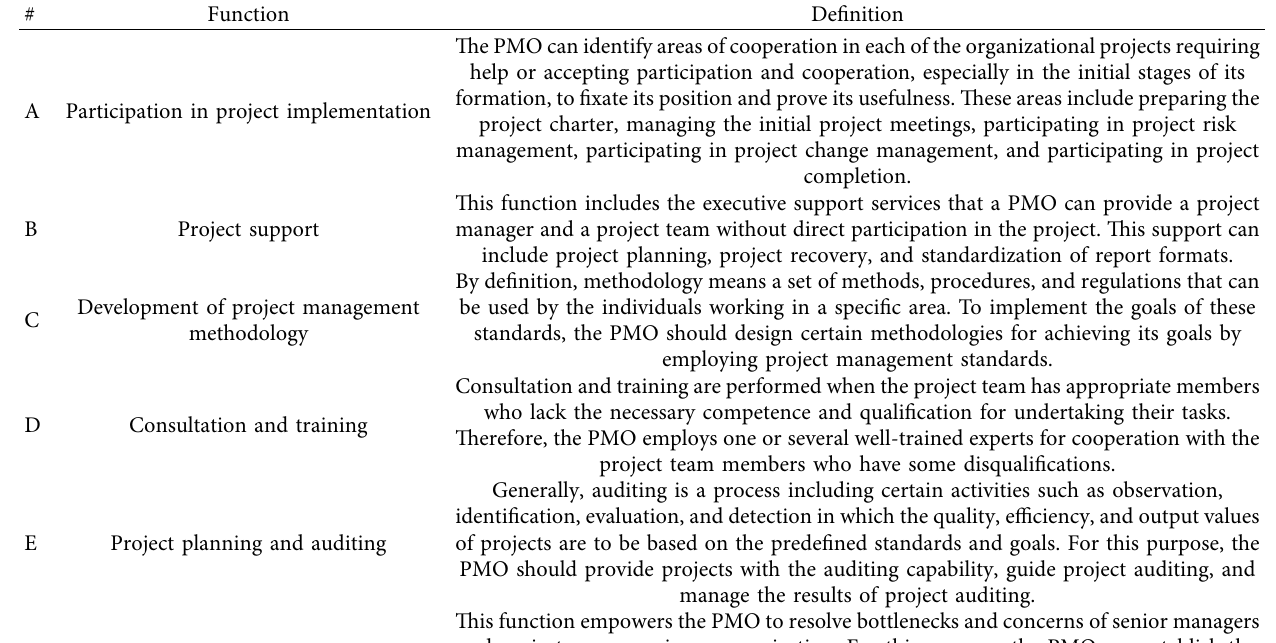
Table 5: The final list of potential PMO